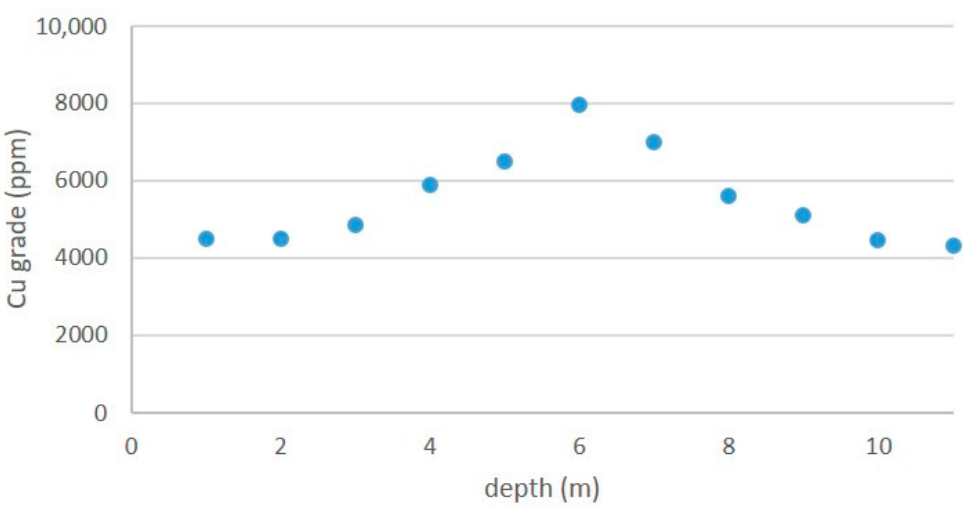
Figure 3. Copper grade for all samples (every sample represents 1 m of drilling). The target depth was 7 m, except for the crest of the embankment, where up to 11 m depth was drilled and sampled.